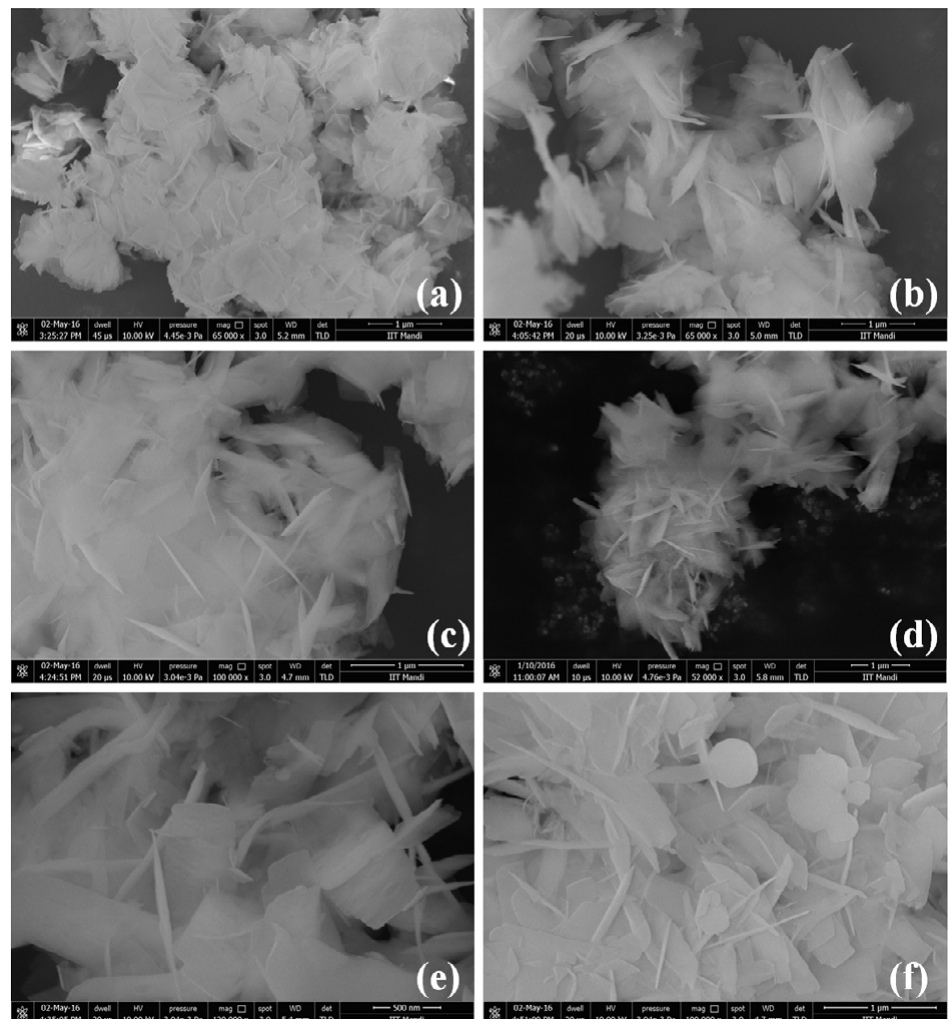
Fig. 2 SEM images for (a) undoped and 20%Yb 3+ /2%Er 3+ doped NaLuF nanocrystals with different Gd 3+ contents: 4 (b) 0% (c) 10% (d) 20% (e) 30% (f)